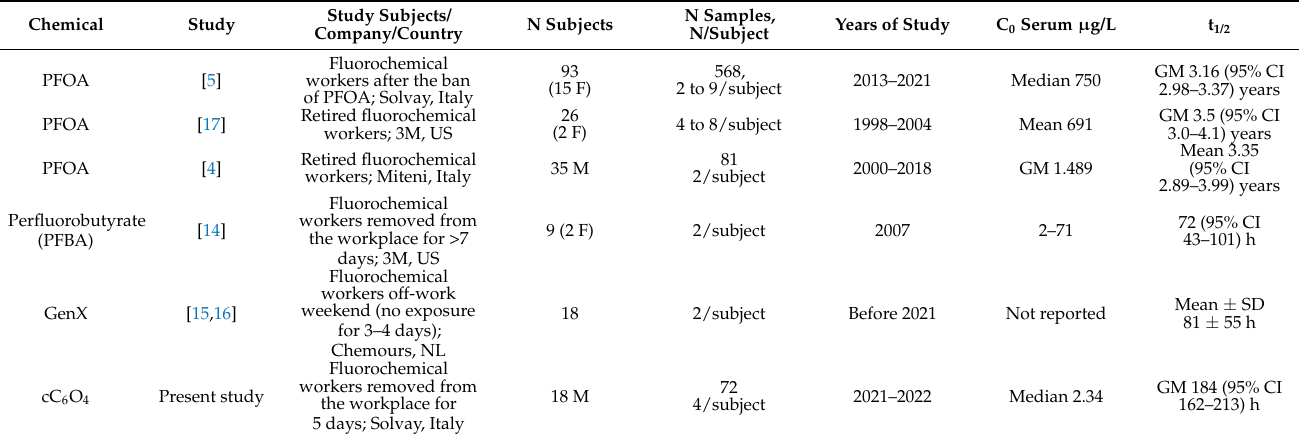
Table 5. Summary of studies investigating the half-life of some PFAS in occupationally exposed